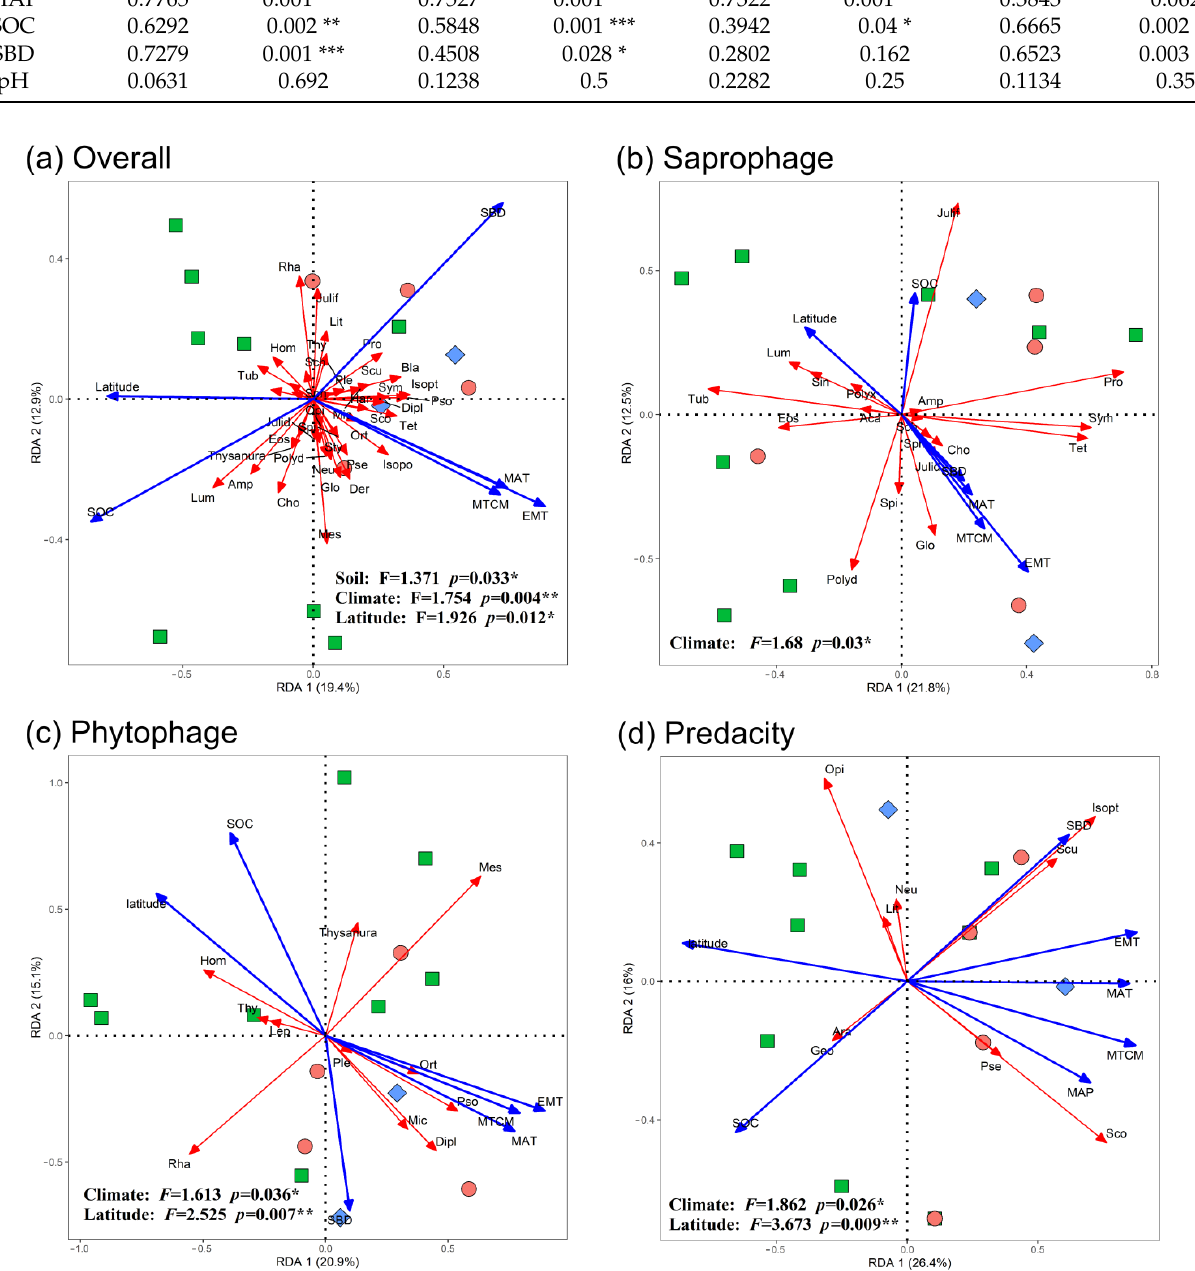
Figure 4. Ordination diagram for the RDA analysis for soil fauna distribution and environmental factors in East Asia. ( a – d ) present the overall, phytophagous, predatory and saprophagous soil fauna orders, respectively. The blue and red arrows represent environmental factors and orders, respectively. The red circles, green squares and blue diamonds represent temperate, subtropical and